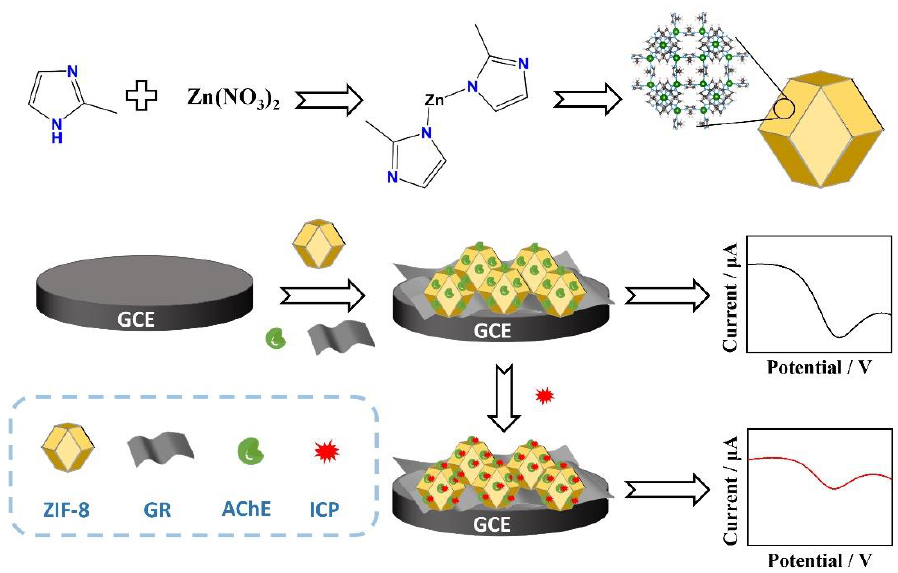
Scheme 1. Schematic diagram of the construction of the AChE-CS/GR/ZIF-8/GCE sensor for ICP